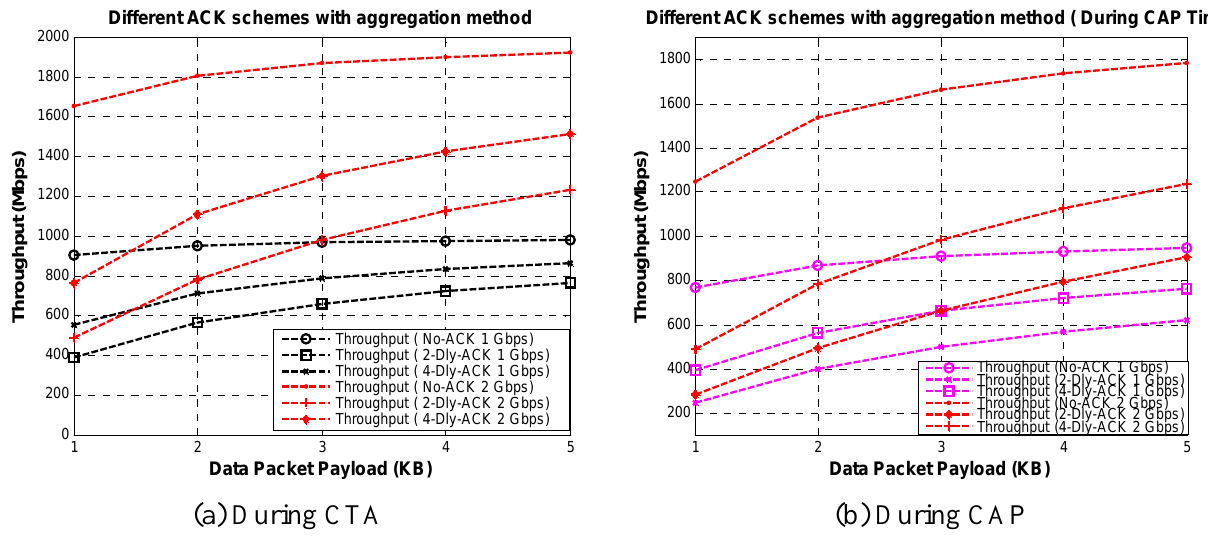
Figure 9. Throughput versus payload size with different ACK policies with aggregation during CTA and CAP.